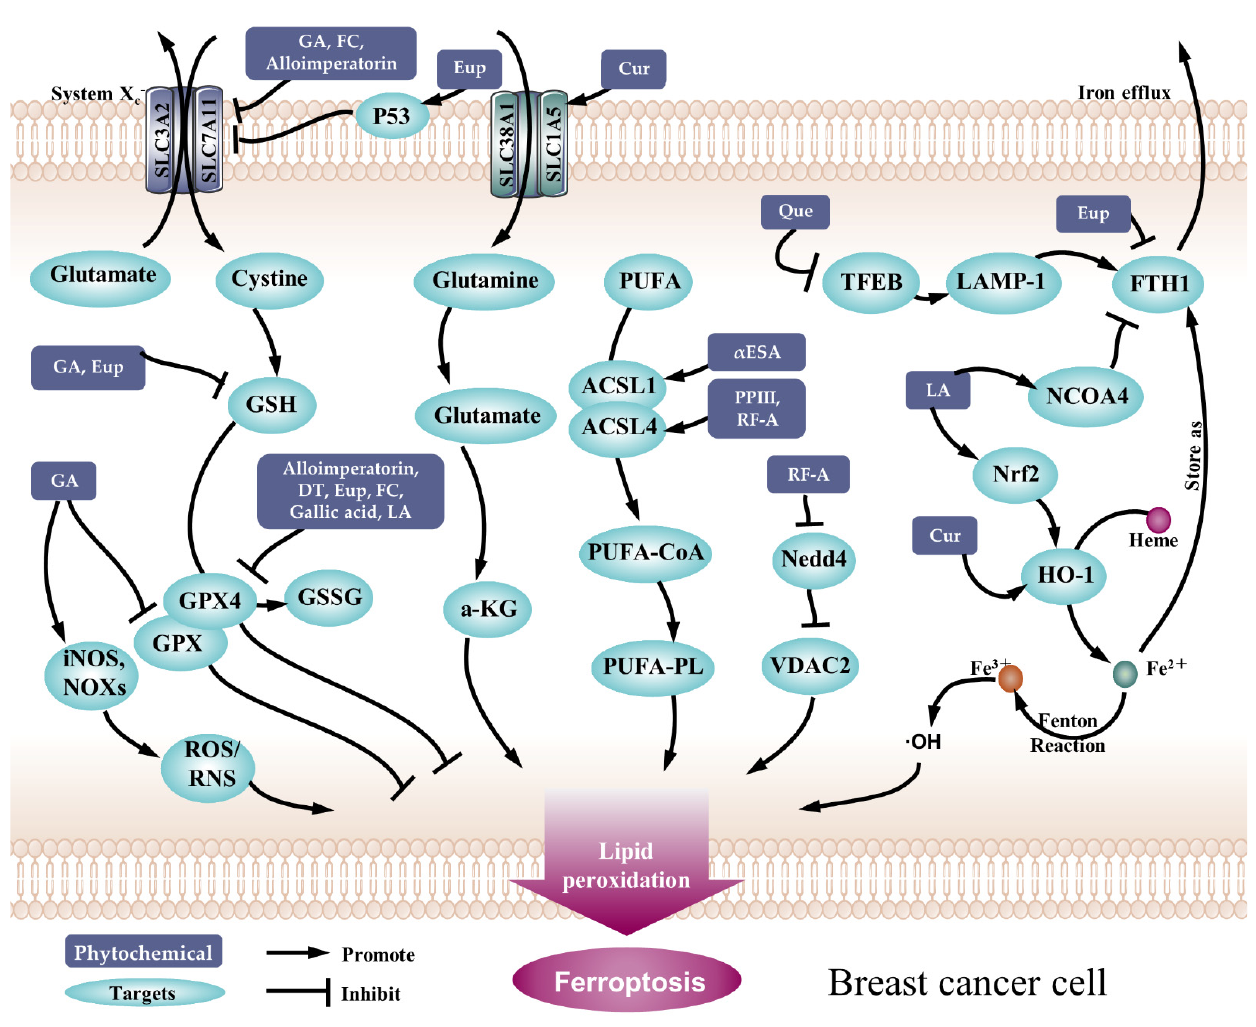
Figure 3. The action mode of phytochemicals inducing ferroptosis in breast cancer cells. Abbrevia-